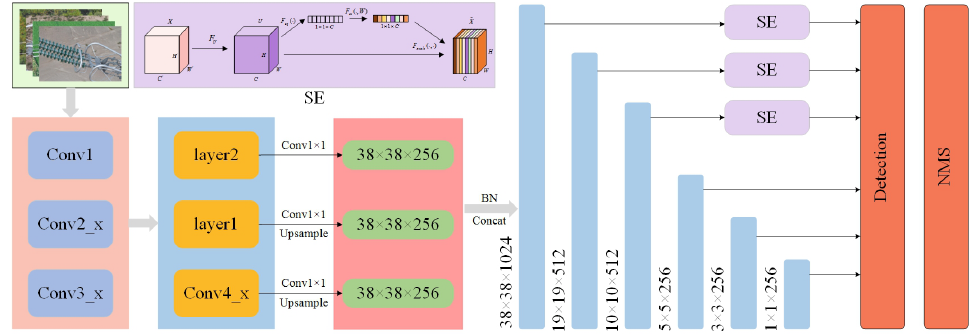
Figure 6. Structure of the FA-SSD